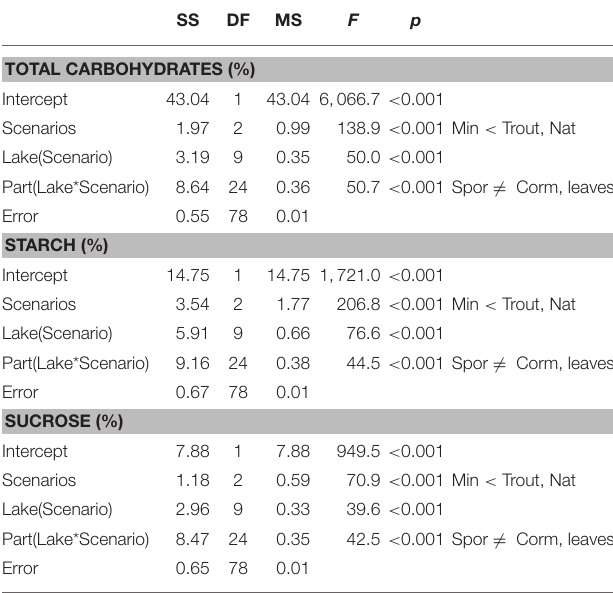
TABLE 5 | Summary of the Nested ANOVAs [var = Scenario + Lake (Scenario) + Part (Lake * Scenario) + error] of Isoetes lacustris carbohydrate storage (total, sucrose and starch) under the different lake scenarios (Nat = fishless, trout, Min = minnows).